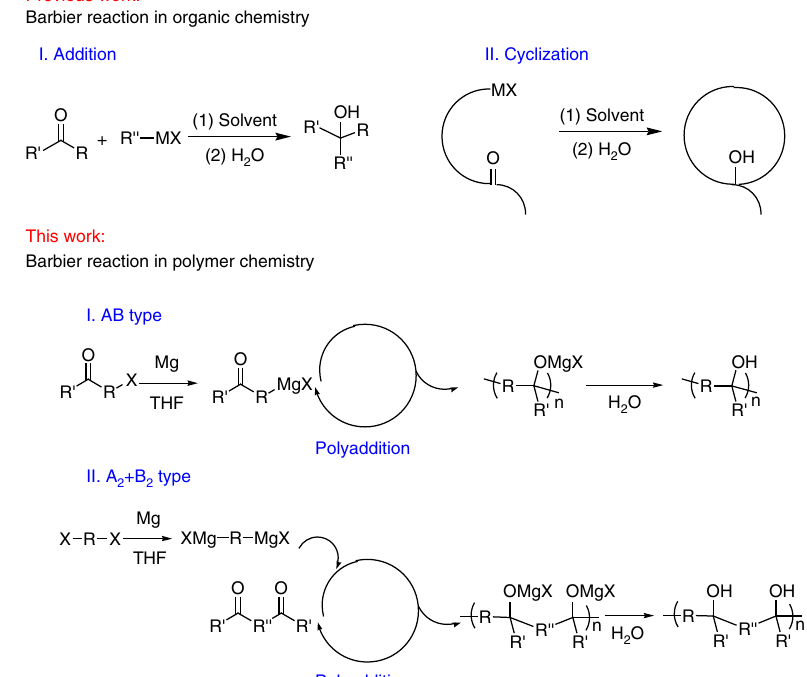
Fig. 1 Introducing the Barbier reaction to polymer science. Widespread Barbier reaction in organic chemistry with small molecules synthesized in literatures; successful Barbier reaction in polymer chemistry (via both AB type and A 2 +B 2 type Barbier polyaddition) with polymers synthesized in this